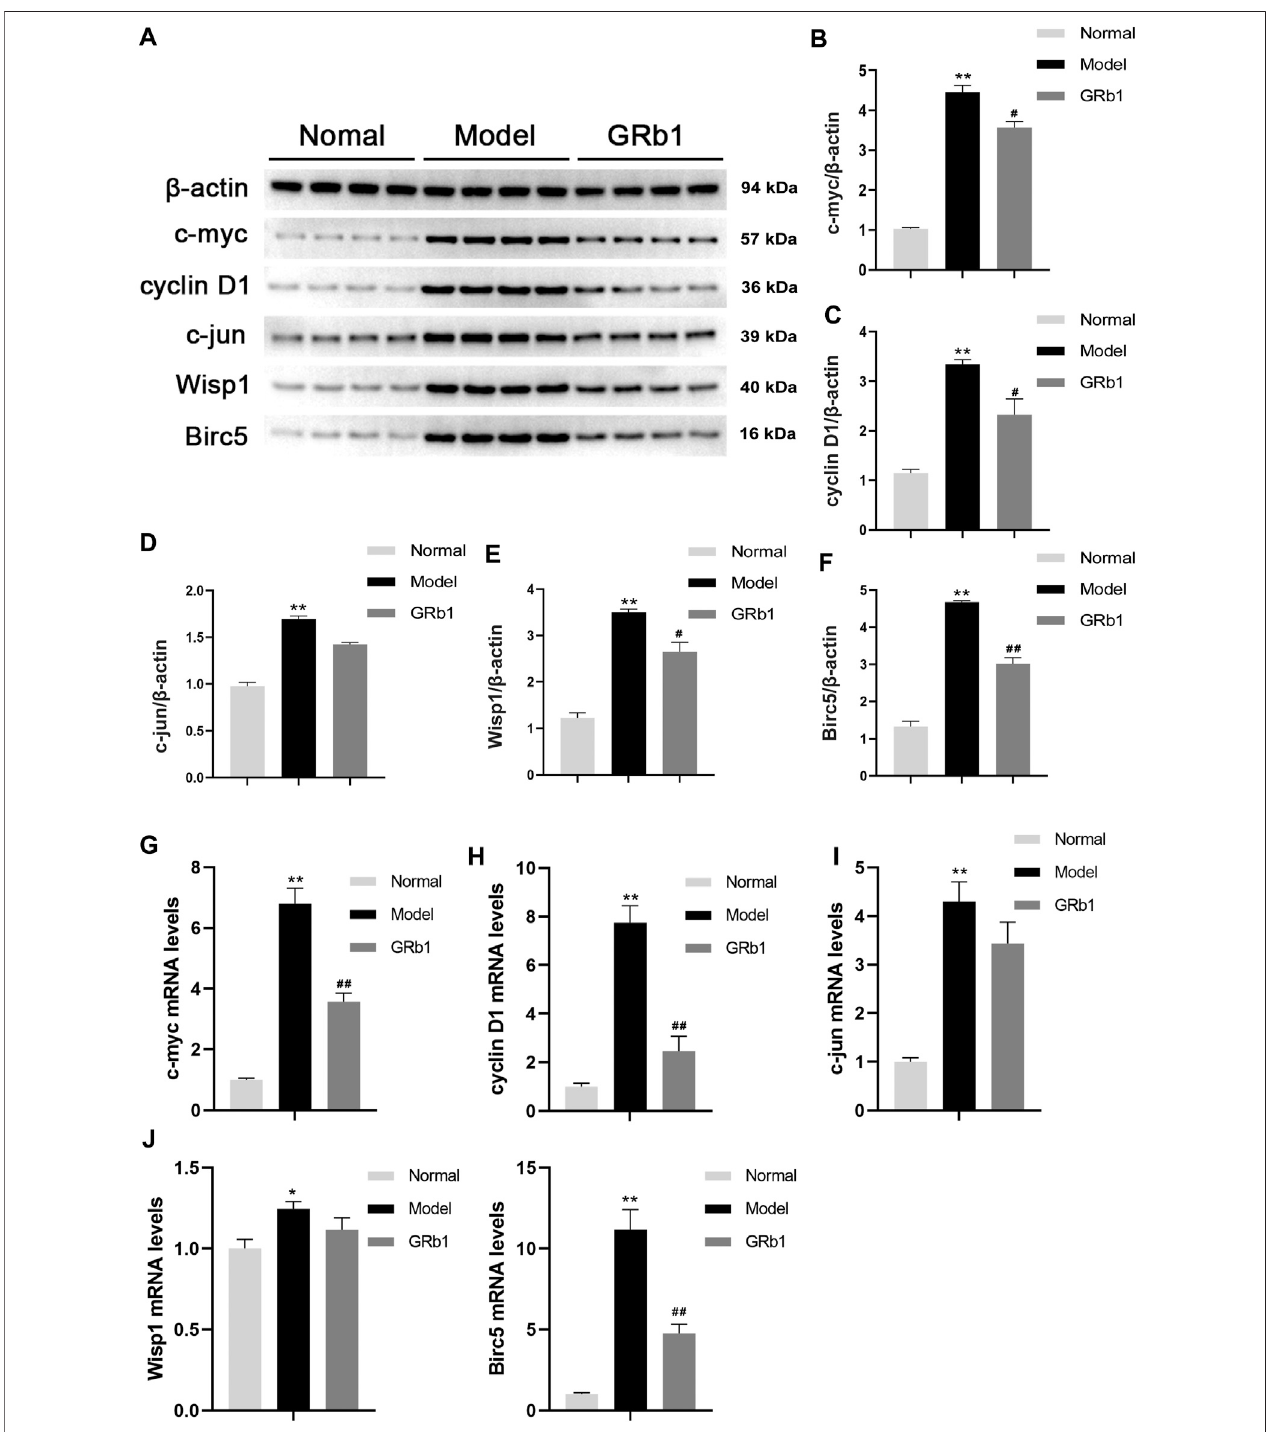
FIGURE5|(A) EffectsofGRb1ontheproteinexpressionlevelsofc-myc,cyclinD1,c-jun,Wisp1andBirc5inGPLmodelrats. (A) Representativewesternblotting bands ofc-myc, cyclinD1, c-jun, Wisp1 and Birc5. Quantitative analysisof (B) c-myc, (C) cyclin D1, (D) c-jun, (E) Wisp1, and (F) Birc5 in western blotting bands ( n (cid:1) 4). Effects of GRb1 on mRNA levels of c-myc, cyclin D1, c-jun, Wisp1 and Birc5 in GPL model rats. Quantization for mRNA levels of (G) c-myc, (H) cyclin D1, (I) c-jun, (J) Wisp1, and (K) Birc5 in gastric epithelium from each group ( n (cid:1) 6).* p < 0.05 and ** p < 0.01 vs. Normal group. # p < 0.05 and ## p < 0.01 vs. Model group. Data are presented as mean ± SEM. Abbreviations: GRb1, ginsenoside Rb1; GPL, gastric precancerous lesions; SEM, standard error of mean.